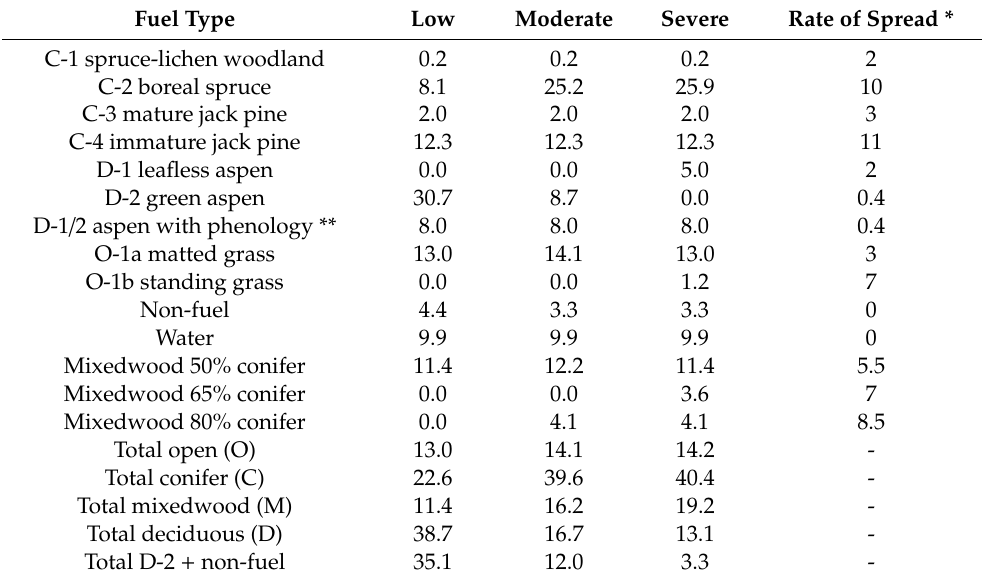
Table 2. Fractional cover of fuel type per drought scenario (Low, Moderate, Severe), including both wetland (dynamic to drought) and upland (static) fuels. For instance, mixedwood 50% conifer includes both upland, static areas (11.4%), and an additional 0.8% of the landscape converted to M–2 with 50% conifer only in the moderate